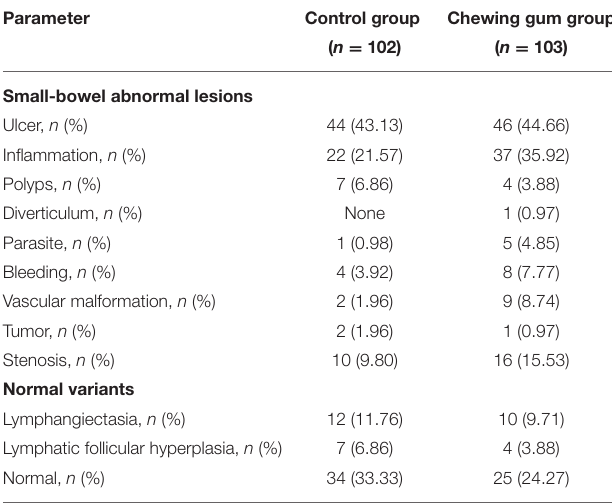
TABLE 3 | Findings of capsule endoscopy examination.